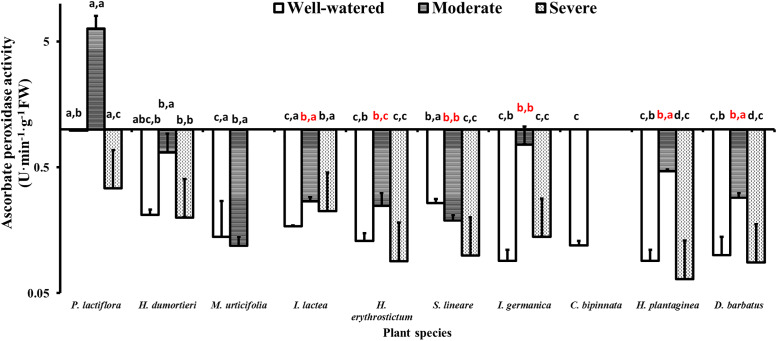
Variance of ascorbate peroxidase activity of the ten species under the drought stress tests.The histogram shows the mean values. Above the histogram, the lowercase letters before the commas indicate statistical significance among the different plant species, and the lowercase letters after the commas indicate statistical significance among the well-watered, moderate and severe drought stress treatments. The different lowercase letters indicate a significant difference at P<0.05.